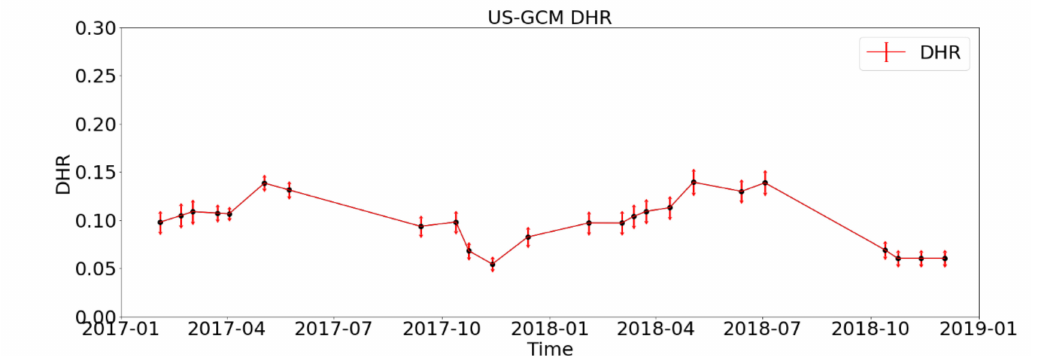
Figure 11. Example of upscaled bi-hemispherical reflectance (BHRs) and uncertainty values at the US-GCM